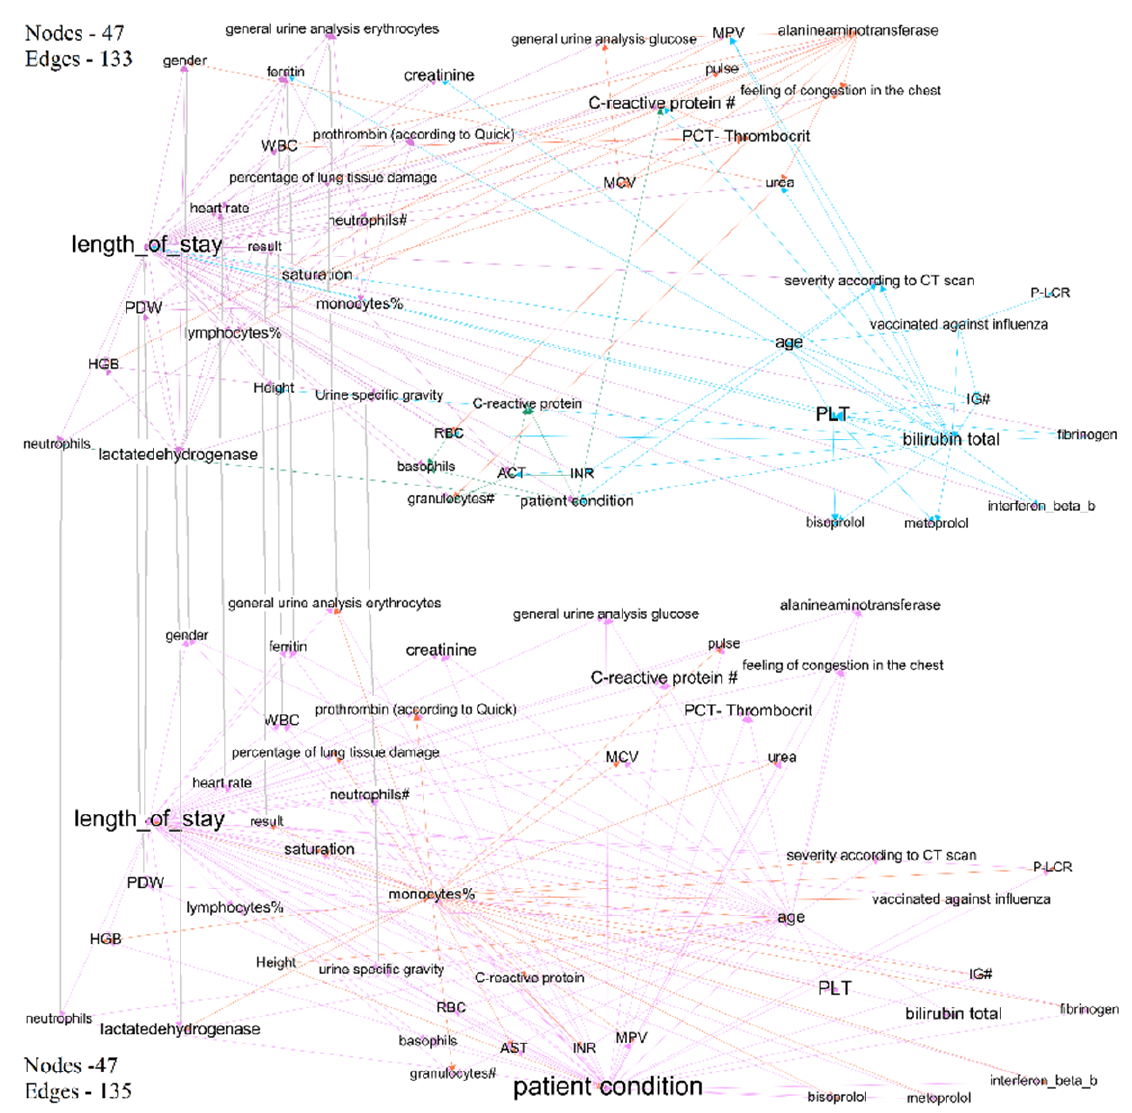
Figure 4. Graphs of trained BN for two-time intervals—first-time interval (top) and last-time interval (bottom). The colors represent nodes’ modularity maximization clustering. The size of each node is weighted degree.